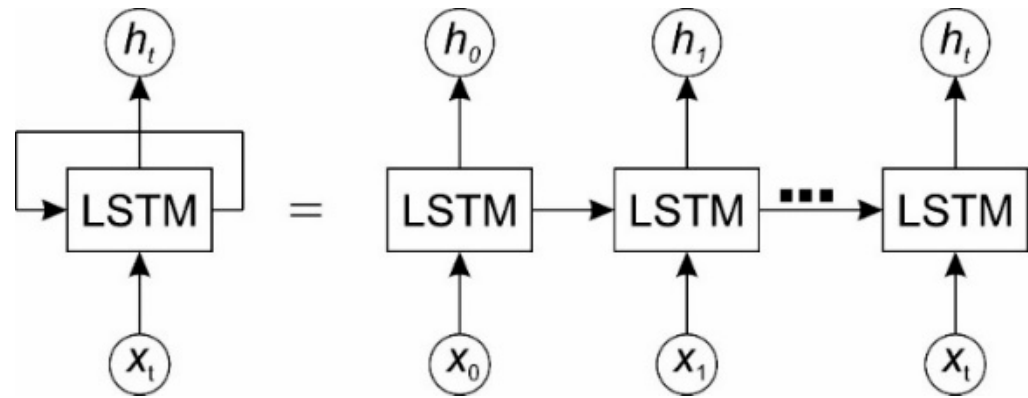
Figure 6. An unrolled LSTM.